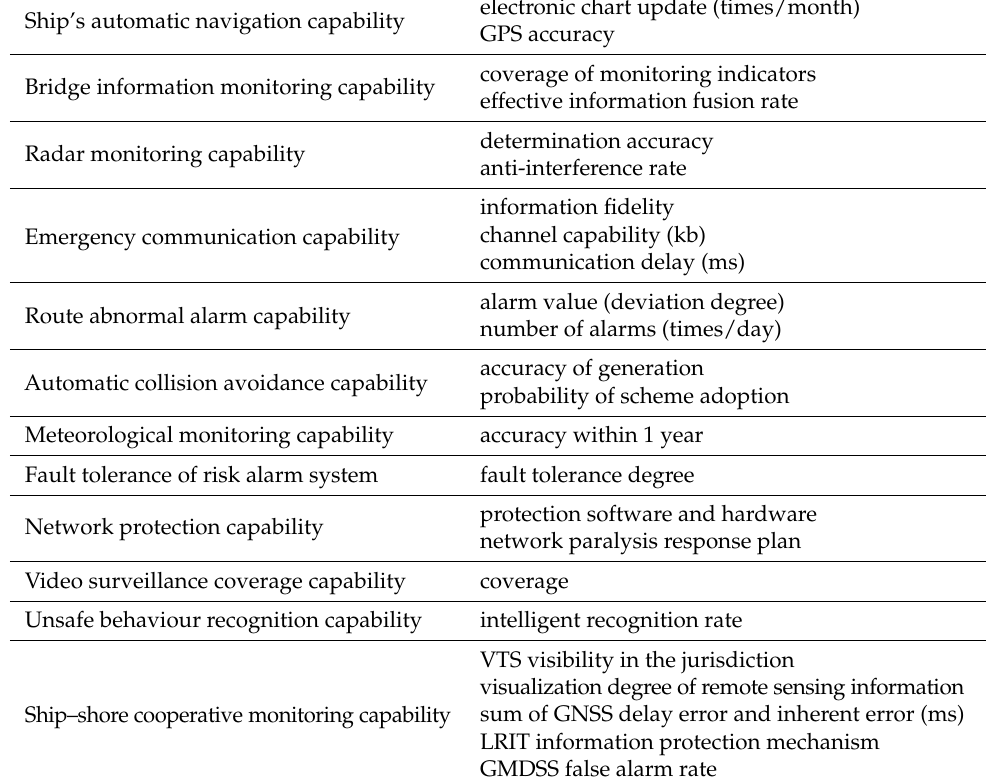
Table 6. Capability indicators of technical